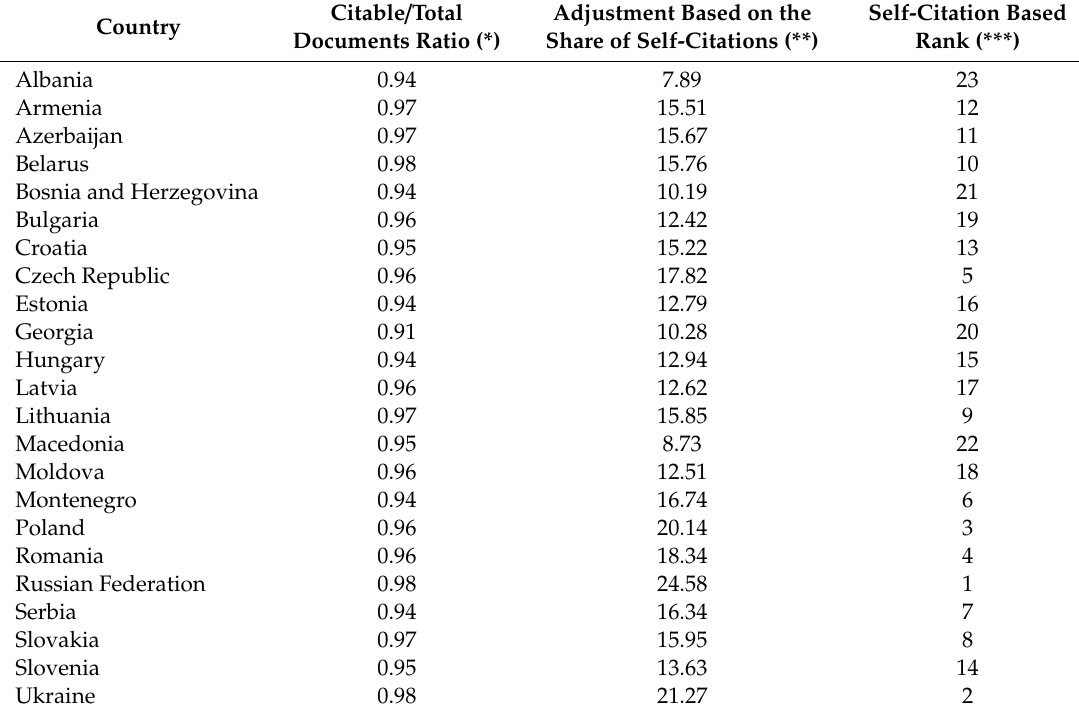
Table 3. Analysis of the e ff ects due to citable documents and self-citations on the number of citations per document in Eastern European countries